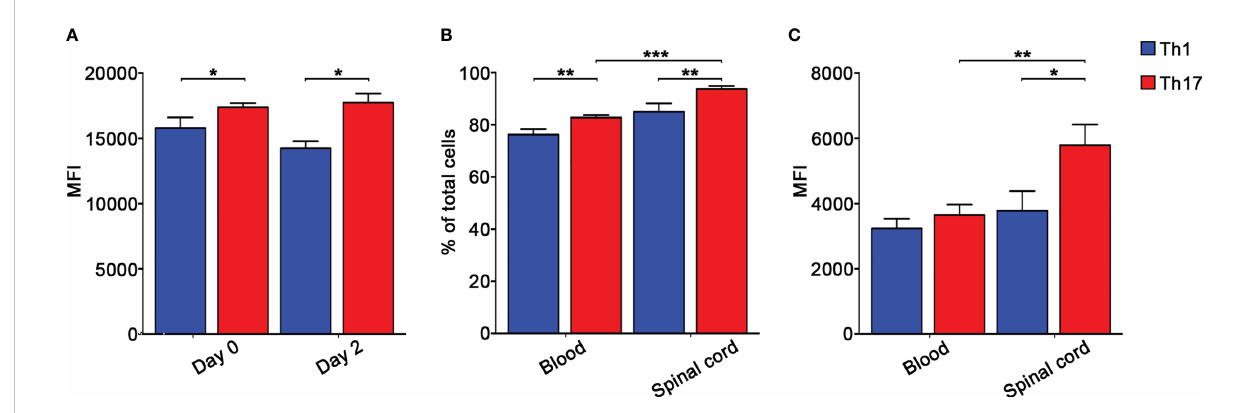
FIGURE 4 Endogenous and in vitro polarized Th17 cells express higher levels of a 4 b 7 integrin compared to Th1 cells. (A) CMAC-labelled in vitro polarized Th1 or Th17 cells were intravenously injected into different EAE recipient mice at disease onset and harvested from the spinal cord 48 hours later. a 4 b 7 integrin expression by Th1 (blue) and Th17 (red) cells was evaluated before and after cell transfer and shown as MFI. Data are expressed as mean ± SEM from 3-4 mice for each Th cell subset. Statistical signi fi cance was calculated using the Mann – Whitney test (* P < 0.05). Endogenous Th cell subpopulations were identi fi ed according to their chemokine receptors expression patterns. Particularly, CXCR3+ CCR4- CCR6- CD4+ T cells were classi fi ed as Th1 cells, whereas CXCR3- CCR4+ CCR6+ CD4+ T cells were classi fi ed as Th17 cells. (B) The percentages of a 4 b 7 integrin-expressing endogenous circulating and spinal cord-in fi ltrating Th1 (blue) and Th17 (red) cells were evaluated by fl ow cytometry after surface staining. Data are expressed as mean ± SEM from 5-8 mice. Statistical signi fi cance was calculated using the Mann – Whitney test (** P < 0.01; *** P < 0.001). (C) MFI shows that endogenous spinal cord in fi ltrating Th17 cells display the highest level of a 4 b 7 integrin. Data are expressed as mean ± SEM from 5-8 mice. Statistical signi fi cance was calculated using the Mann – Whitney test (* P < 0.05; ** P <